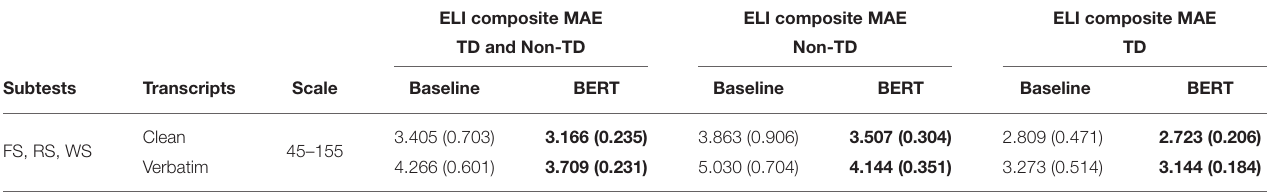
TABLE 5 | Mean absolute error (MAE) and standard deviation for expressive language index (ELI) composite score with lookup table applied to scaled score estimation.